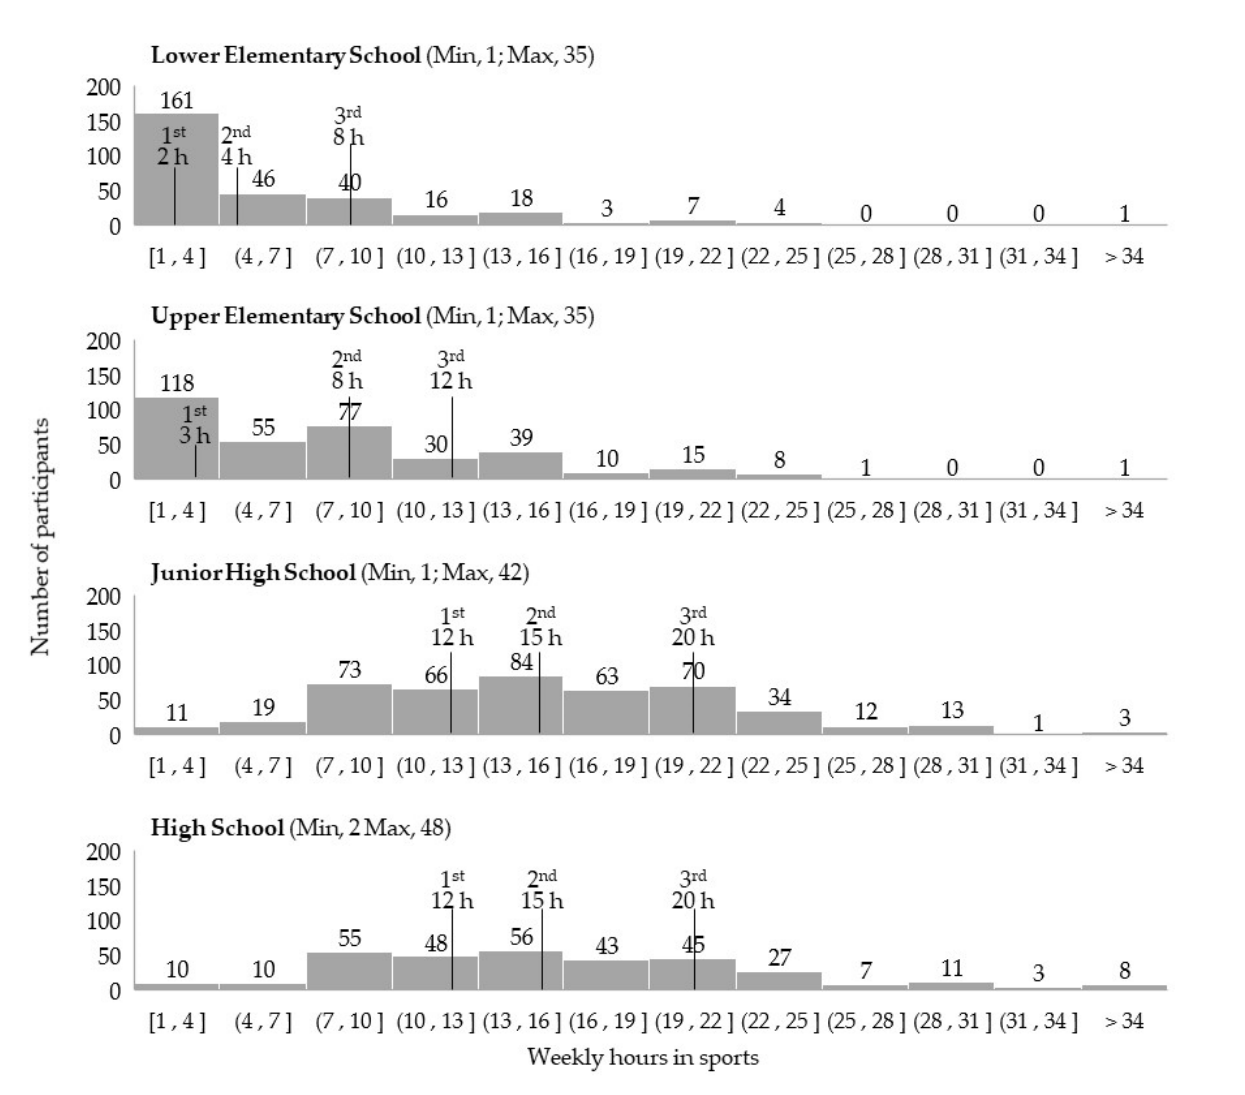
Figure 2. Distributions of weekly hours in sports by school category. 1st, 2nd, and 3rd: First to third quartile of weekly hours, (x, y]: x or longer, but less than y.